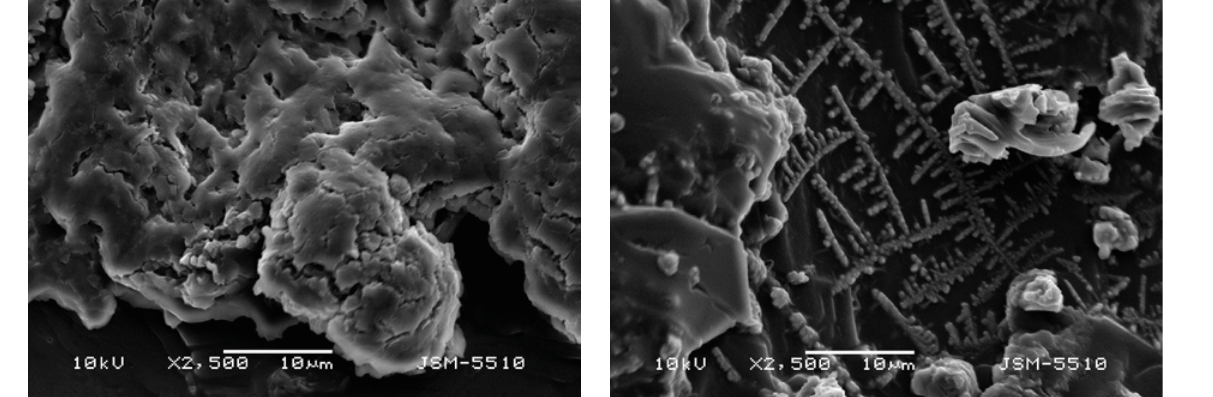
Figure 9. SEM of the Ca-1 sample after 1 day immersion in 1.5 SBF Figure 10. SEM of the Ca-2 sample after 1 day immersion in 1.5